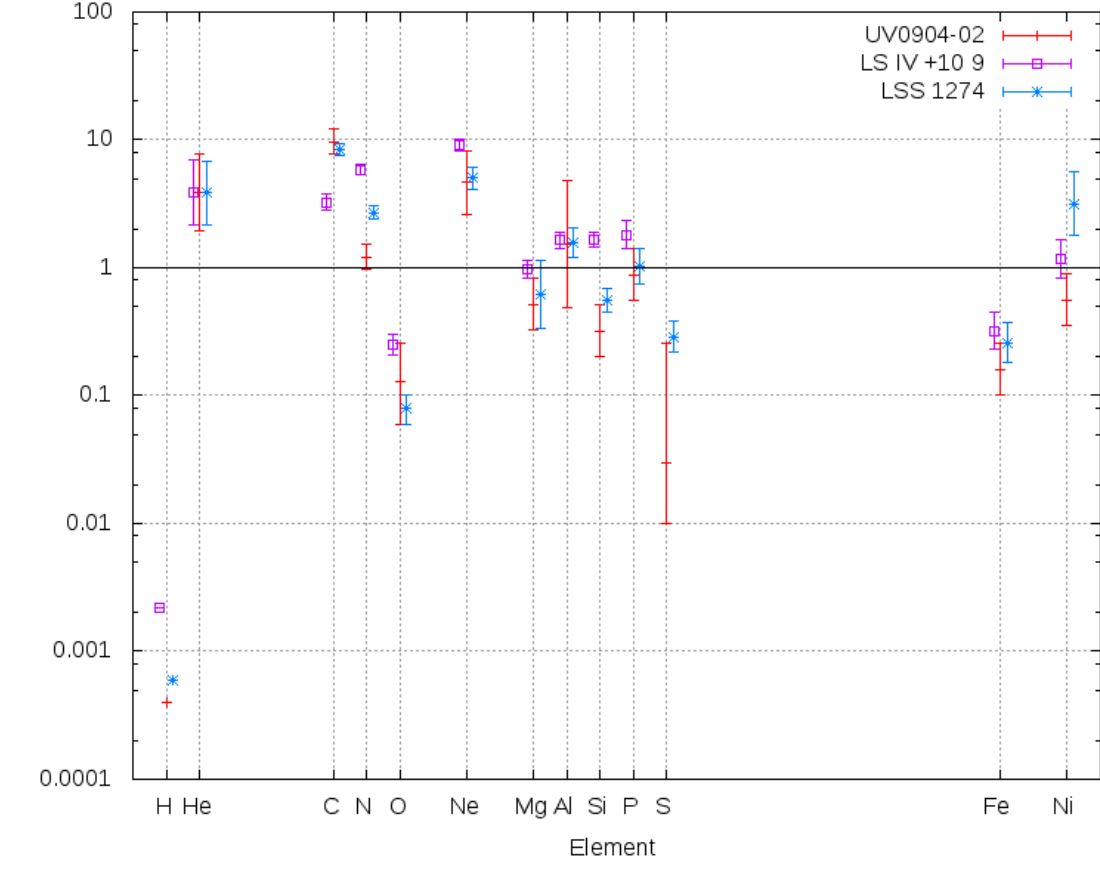
Figure 5. Abundance pattern of CN-rich He-sdO stars.Given is the relative mass abundance compared to the sun. The solar value is indicated by the black line.